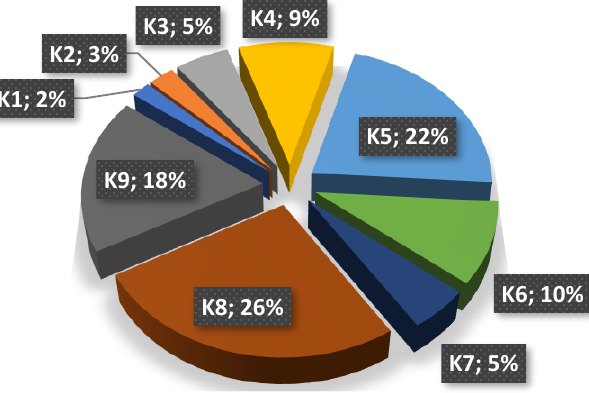
Figure 7. Weighted criteria expressed as percentages, according to Expert 4.